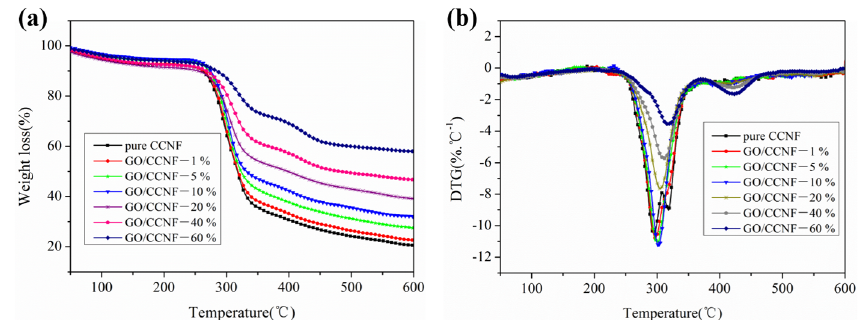
Figure 3. Thermal stability of GO/CCNF films. ( a ) TG curves; ( b ) DTG curves.